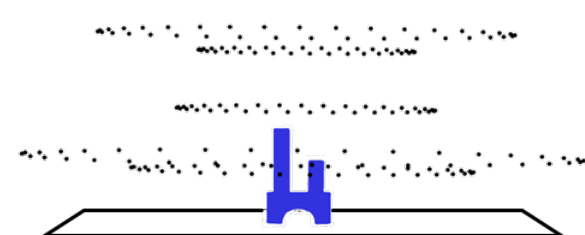
Figure 2. Dry-lab tests evaluated SfM data quality resulting from photographs and videos collected using different cameras, camera settings, light configurations, and with and without the stability of HEXYZ-1.